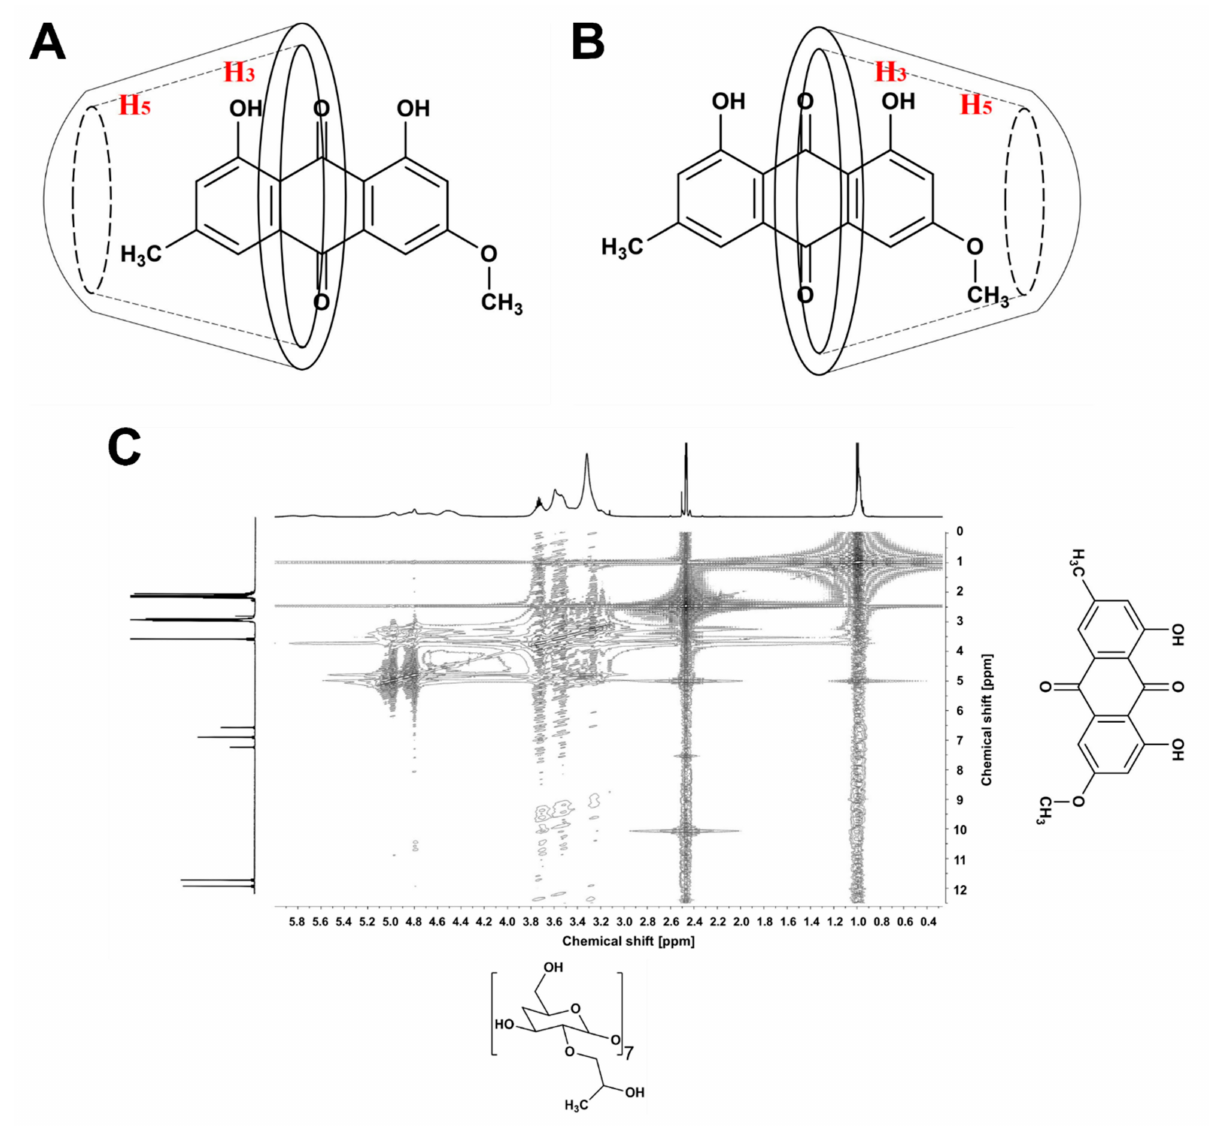
Figure 3. The possible penetration patterns of PTN through the HP- β -CD cavity by either the methyl ( A ) or the methoxy ( B ) substituted rings. ( C ) ROESY spectrum of the PTN/HP- β -CD complexes in